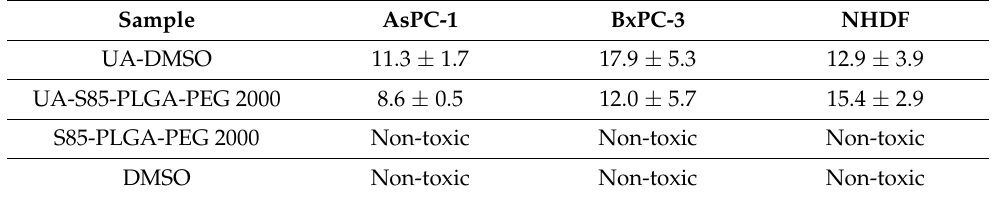
Figure 18. Cytotoxic effect of ursolic acid loaded into S85-PLGA-PEG 2000 hybrid nanoparticles or in the free form in DMSO, as determined by MTT assay, after 72 h of incubation for AsPC-1 panel ( A ), BxPC-3 panel ( B ) and NHDF panel ( C ) cell lines. Non-loaded hybrid particles were tested as well. For a dose of 10 µM, the statistical significance of differences between free and loaded compounds evaluated by GraphPad Prism 7 is indicated by asterisks (0.1234 Ns, 0.0332 *, 0.0021 **, 0.0002 ***, >0.0001 ****), with 95% confidence. Ns stands for “non-significant”. Table 3. Calculated IC50 values for encapsulated and non-encapsulated UA after 72 h of incubation in two PDAC cell lines: AsPC-1 and BxPC-3. NHDF was tested as well as normal cell controls.